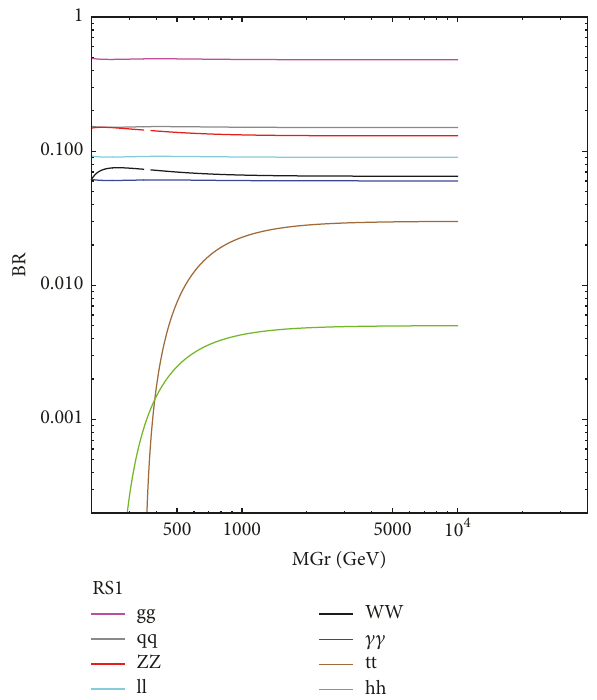
Figure 8: Branching fractions of graviton, G (from